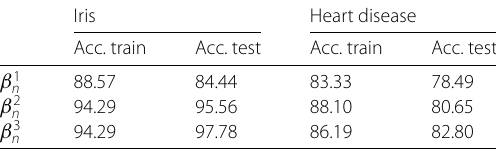
Table 7 Effects of inertial parameters at the 100th iteration